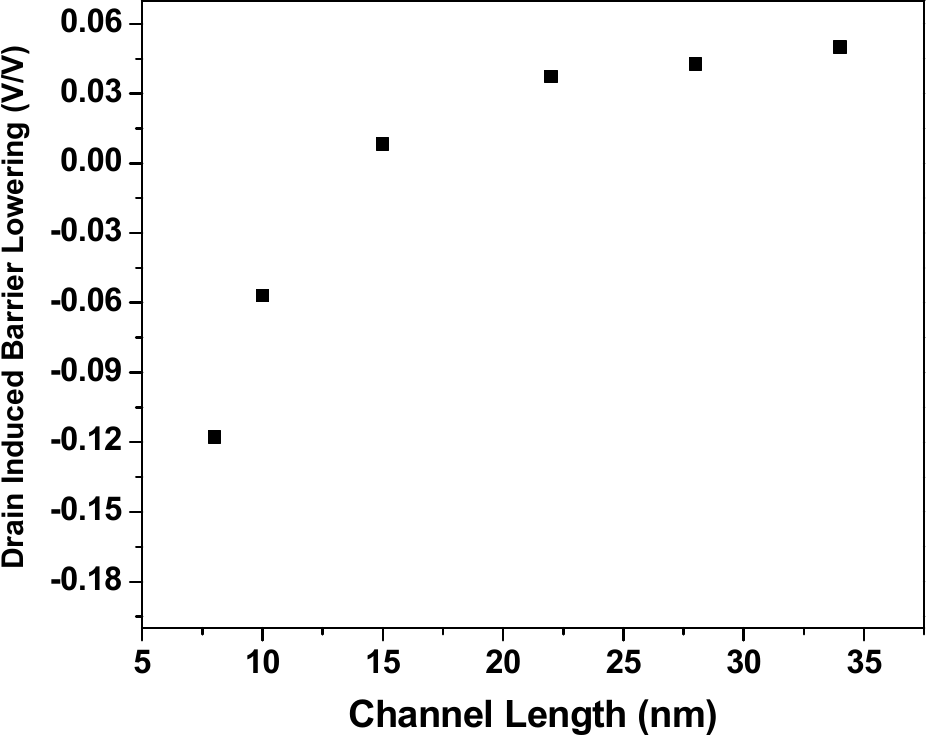
Figure 9. Effect of DIBL (in v / v ) vs. channel length (in nm). This transition into negative values of DIBL for smaller channel lengths (<12 nm) is the result of drain-gate coupling. This effect originated from the coupling of drain-effective gate voltage via gate-drain capacitance. This coupling is caused due to the ferroelectric nature of the oxide capaci- tance [32]. For small values of V G , as the drain voltage increases, the coupling effect in- creases, and this results in conduction dominated by a lateral field (formed due to drain- channel coupling). Therefore, the surface potential at the channel is negative when V G is